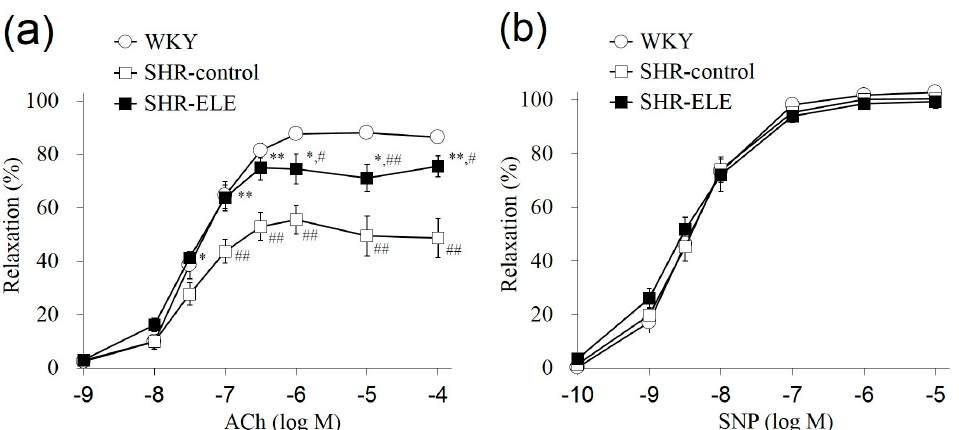
Figure 2. ( a ) Endothelium-dependent relaxation curve induced by acetylcholine (ACh) and ( b ) endothelium-independent relaxation curve induced by sodium nitroprusside (SNP) in thoracic aortic rings from the indicated treatment groups. The values represent the means ± SE; * p < 0.05, ** p < 0.01, as compared with the spontaneously hypertensive rat (SHR)-control group; # p < 0.05, ## p < 0.01, as compared with the Wistar Kyoto rat (WKY) group. ELE, Eucommia leaf extract.